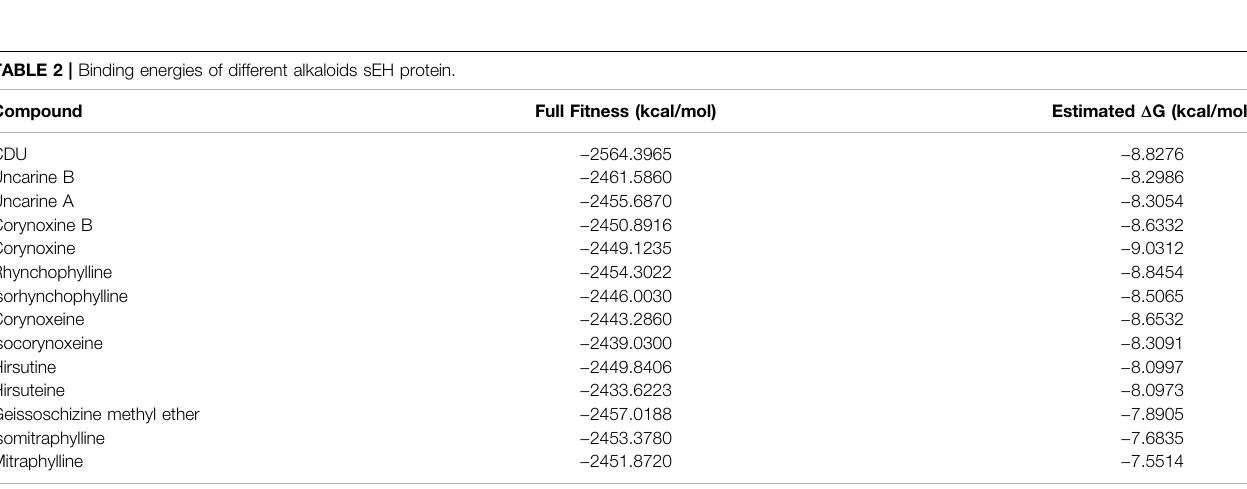
TABLE 2 | Binding energies of different alkaloids sEH